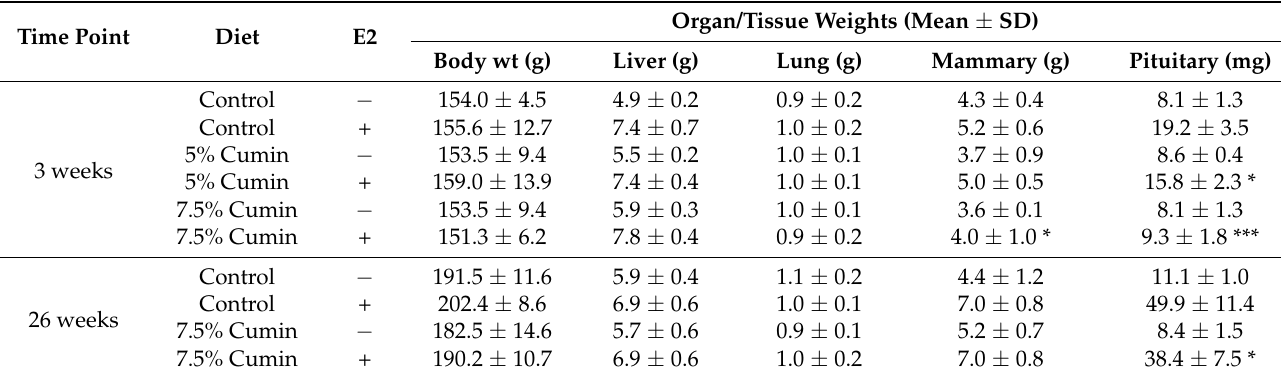
Table 1. Effect on body, organs, and tissue weights by cumin